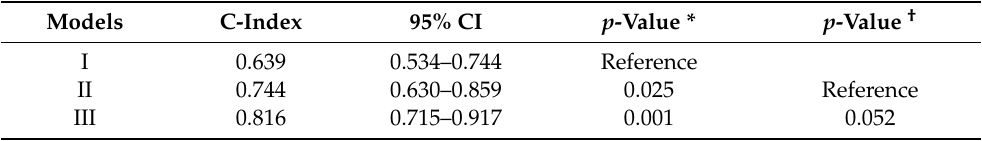
Table 5. Prognostic utilities of models using risk factors for noninvasive ventilation failure.